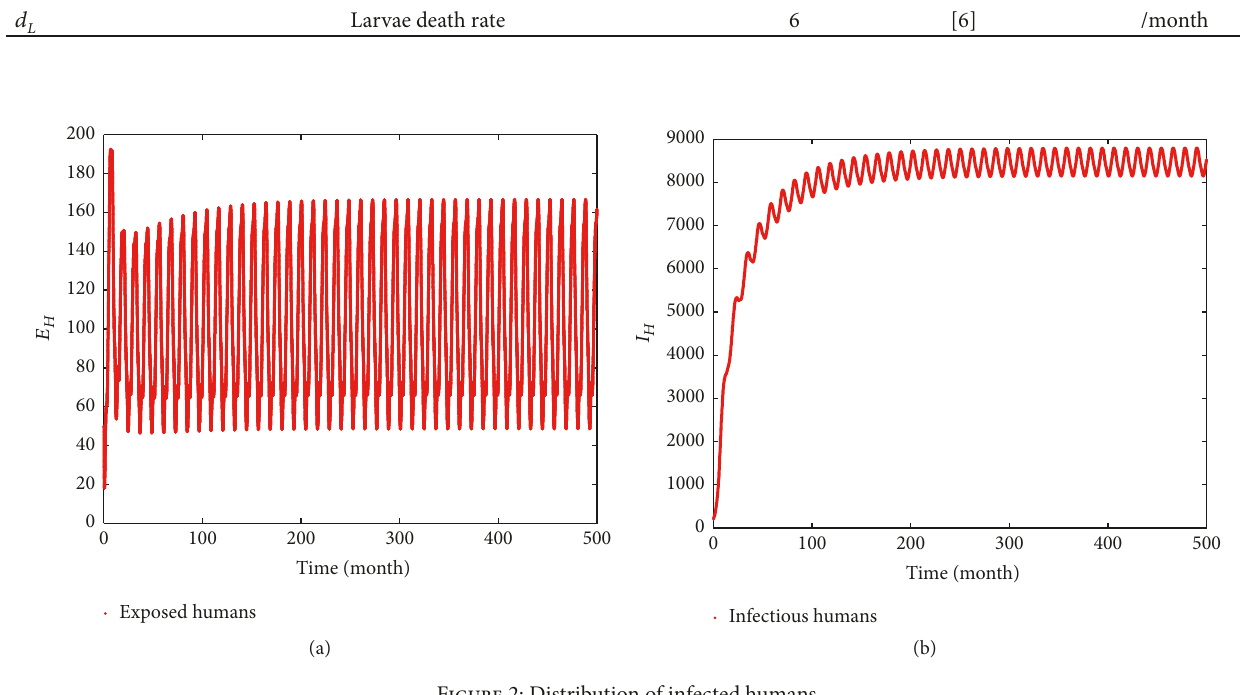
Figure 2: Distribution of infected